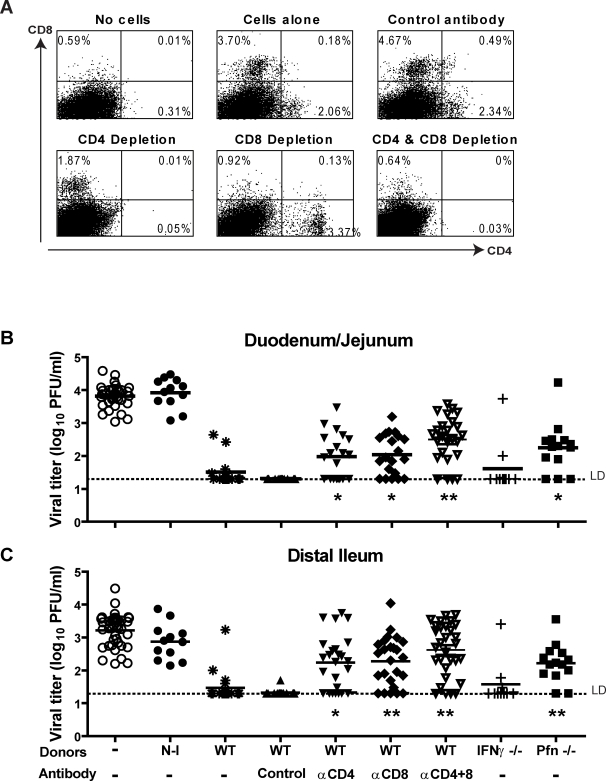
Immune CD4 and CD8 T cells are both required, and perforin plays a role in clearance of persistent MNV infection in RAG1-/- recipients.(A) Representative flow cytometric analysis of splenocytes harvested from RAG1-/- recipient mice 6 days post-transfer of splenocytes. Viral titers in (B) duodenum/jejunum and (C) distal ileum 6 days after adoptive transfer of medium alone, WT non-immune splenocytes (N–I), WT immune splenocytes (WT), WT immune splenocytes with or without depleting antibodies or immune splenocytes from IFNγ-/- or perforin-/- (Pfn-/-) mice. These data are pooled from three independent experiments with 3–5 mice per group in each experiment. (**) indicates p<0.0001, (*) indicates p<0.05. LD indicates the limit of detection.